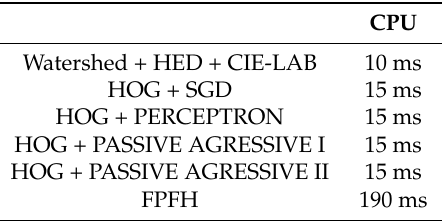
Table 3. Performance time of the different processes in our pipeline.